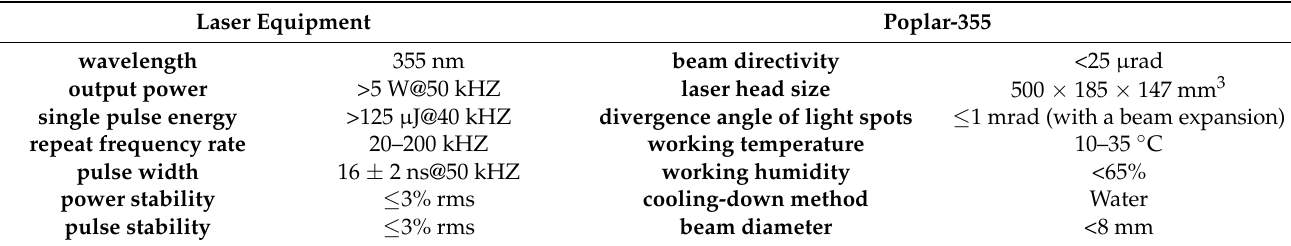
Table 3. Nanosecond laser parameters.